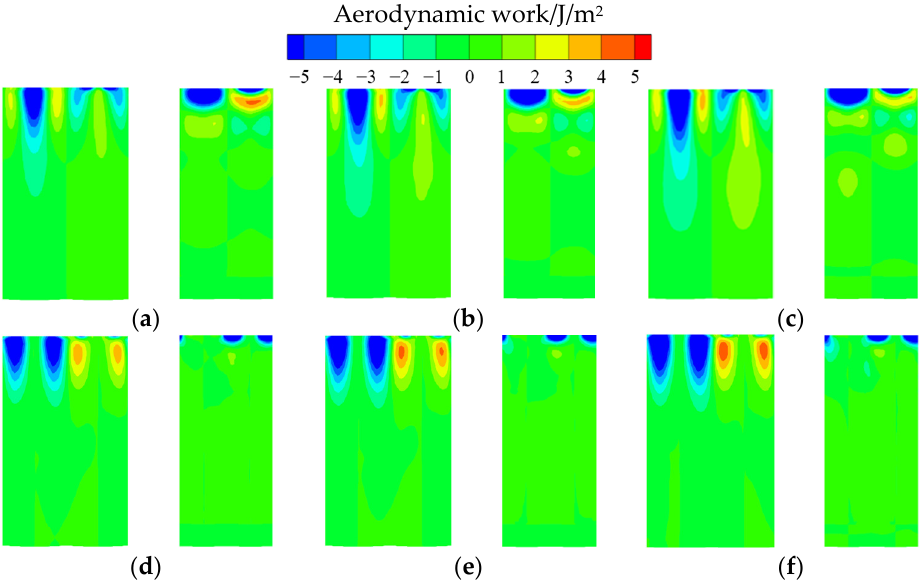
Figure 12. Aerodynamic work distribution of the first and second modes with three typical frequen ‐ cies: ( a ) First mode, 1357 Hz; ( b ) First mode, 1499 Hz; ( c ) First mode, 1581 Hz; ( d ) Second mode, 1357 Hz; ( e ) Second mode, 1499 Hz; ( f ) Second mode, 1581 Hz.